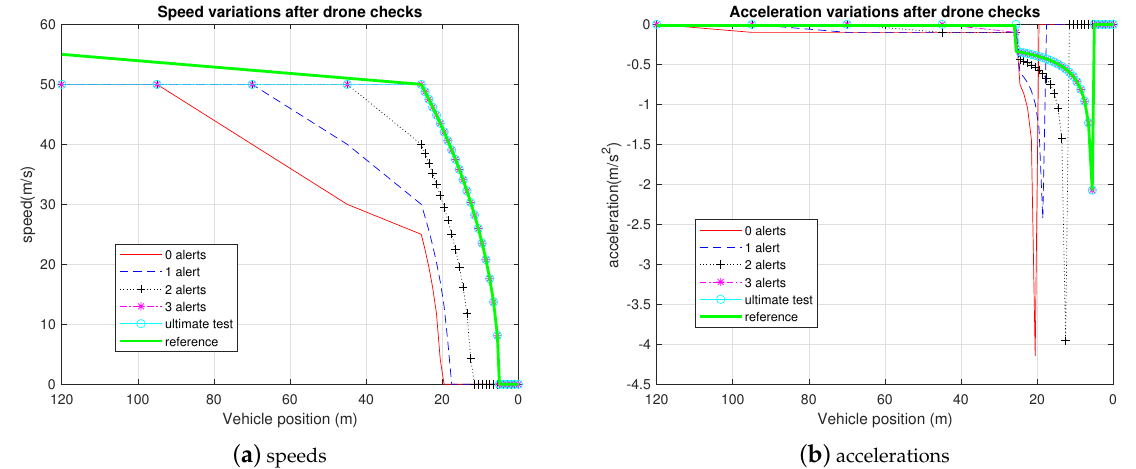
Figure 6. Speeds and accelerations of driver type 1, case of dry straight line.